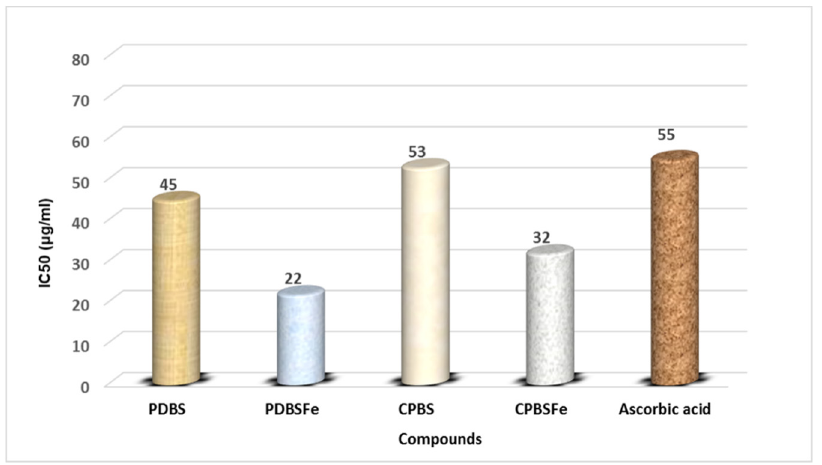
Figure 8. The suppression of the DPPH radical by the PDBS and CPBS imine ligands, and their Fe (III) chelates.